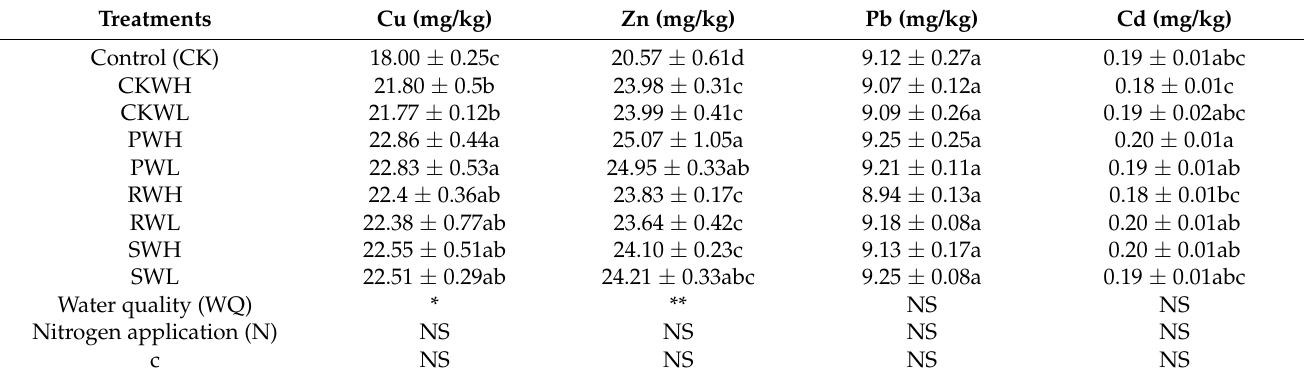
Table 6. Effects of different irrigation treatments on the concentration of soil heavy metals.